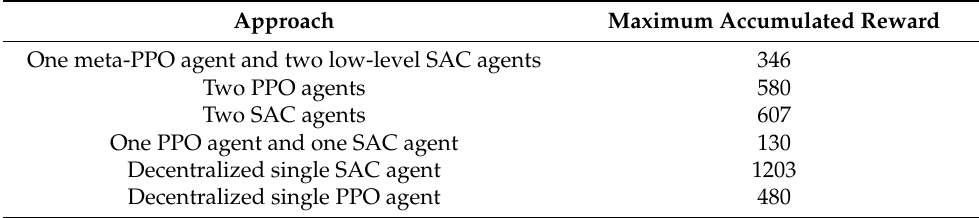
Table 1. Maximum accumulated reward in the first 2M time